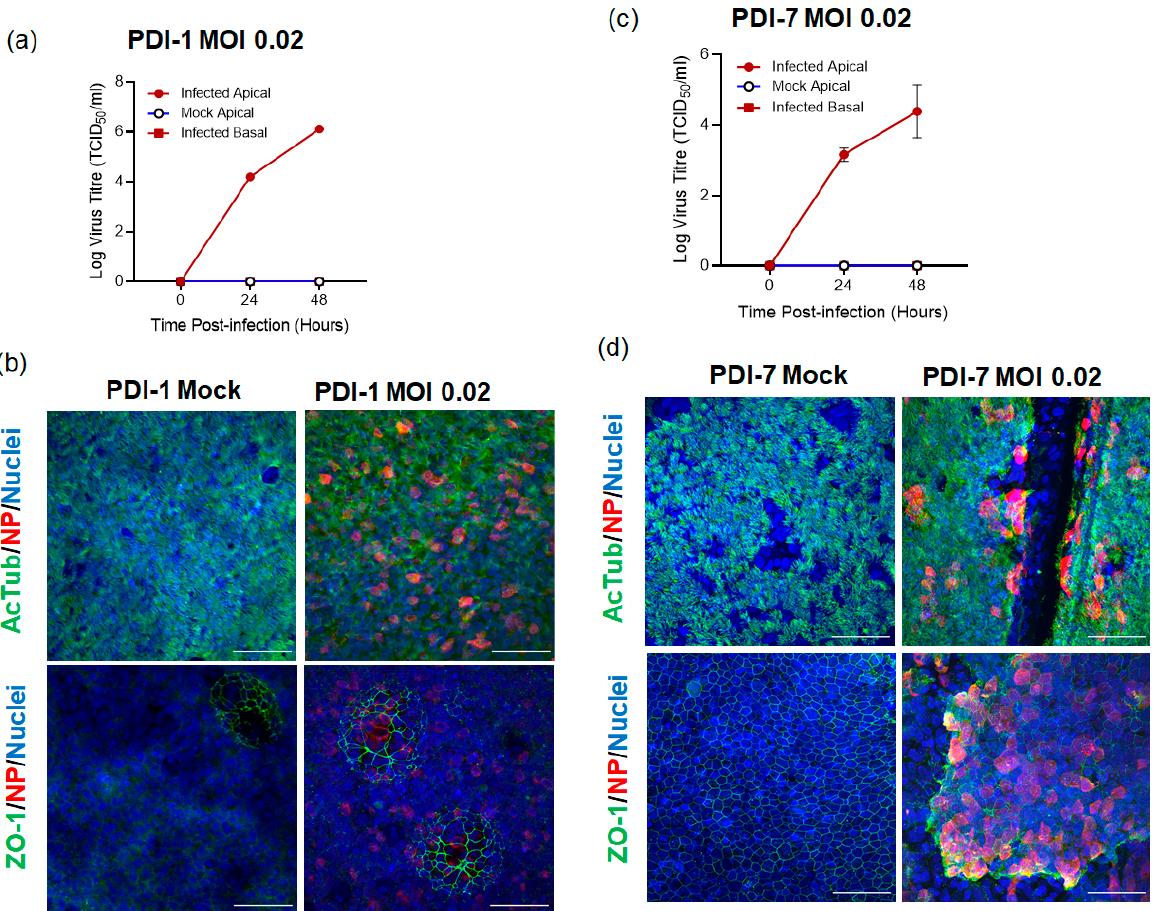
Figure 1. SARS-CoV-2 infected ALI-HNE. Adult ( a , b ) and child ( c , d ) infected with VIC01. ( a , c ) In- fectious virus (TCID 50 ) in the apical wash and basal medium harvested at the indicated times; ( b , d ) Immunofluorescent confocal microscopy staining for α -tubulin (AcTub, green) and nucleoprotein (NP, red). Nuclei are blue (DAPI). Scale bar 50 µm.